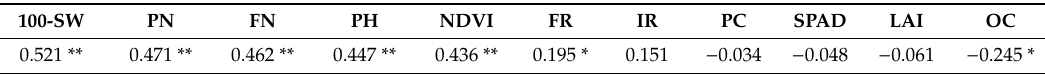
Table 16. Correlation coe ffi cient of yield components, fertilization treatments and irrigation regimes with the final seed yield. (100-SW: 100-seed weight, PN: pod number, FN: flower number, PH: plant height, FR: fertilization rate, IR: irrigation regime, PC: protein concentration, OC: oil concentration).